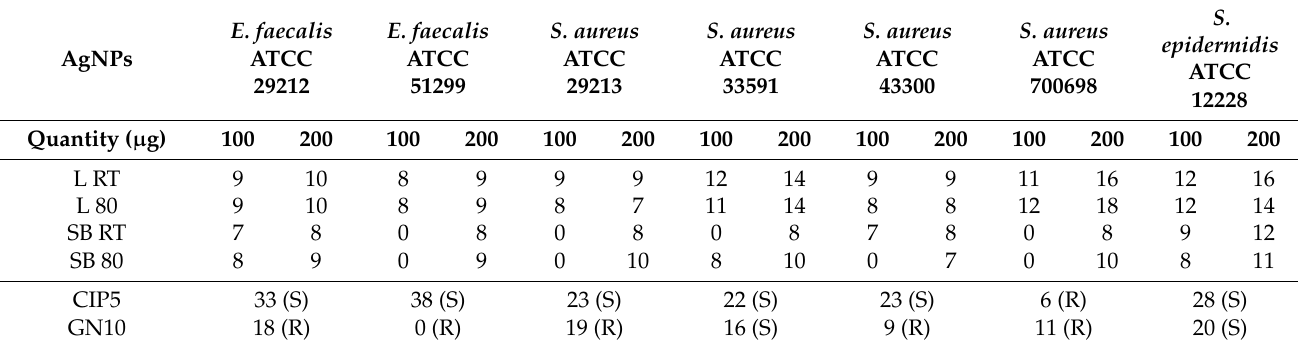
Table 3. Zone of inhibition (mm) of D. villosa leaves and stem AgNPs against Gram-positive bacterial